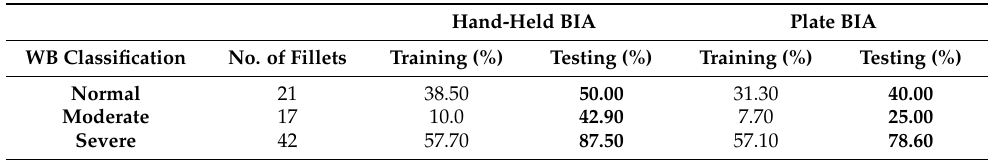
Table 3. K -nearest neighbor classification table for hand-held BIA, and Plate BIA collected parameters occurred with different severity levels of woody breast myopathies. Hand-Held BIA Plate